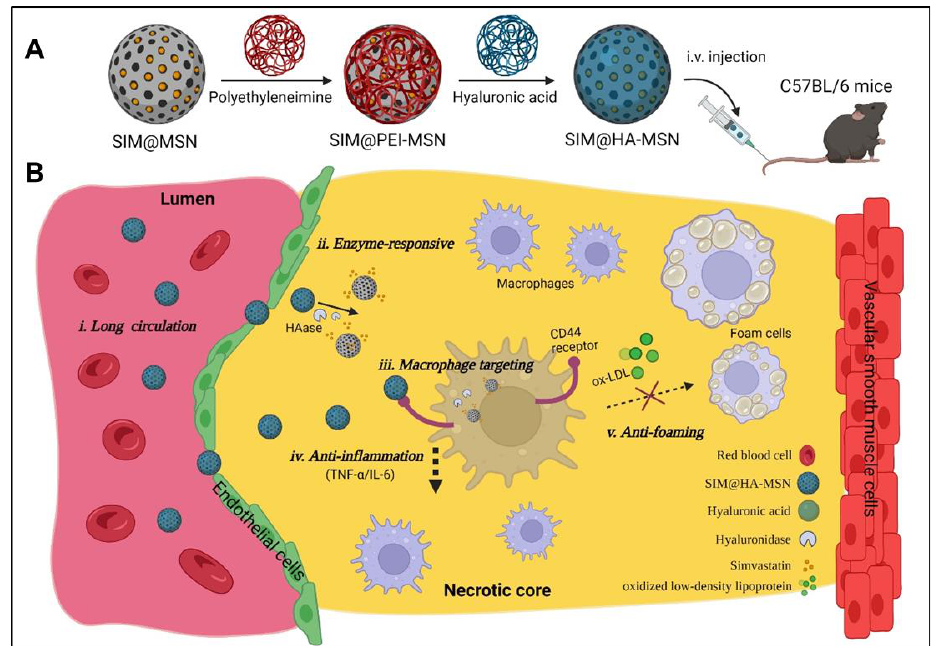
Figure 1. Schematic illustration of construction of SIM@HA-MSN for atherosclerosis management. ( A ) Scheme of fabrication process and administration route of SIM@HA-MSN. ( B ) Illustration of SIM@HA-MSN therapy which can potentially alleviate atherosclerosis through long circulating, enzyme-responsive drug release, macrophage targeting, and anti-inflammatory and anti-foaming effects. (Created by Biorender. )